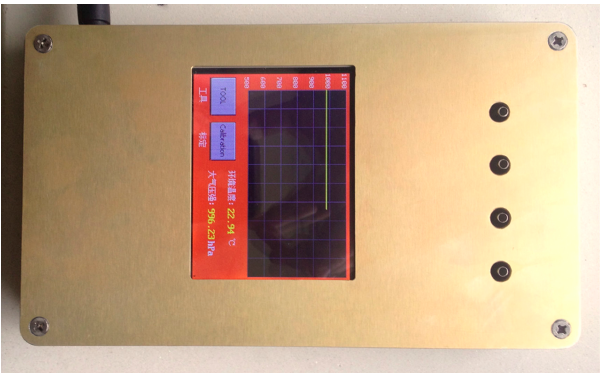
Figure 12. Software implementation process for the GA-WNN compensation algorithm in the µC/OS-II operating system.